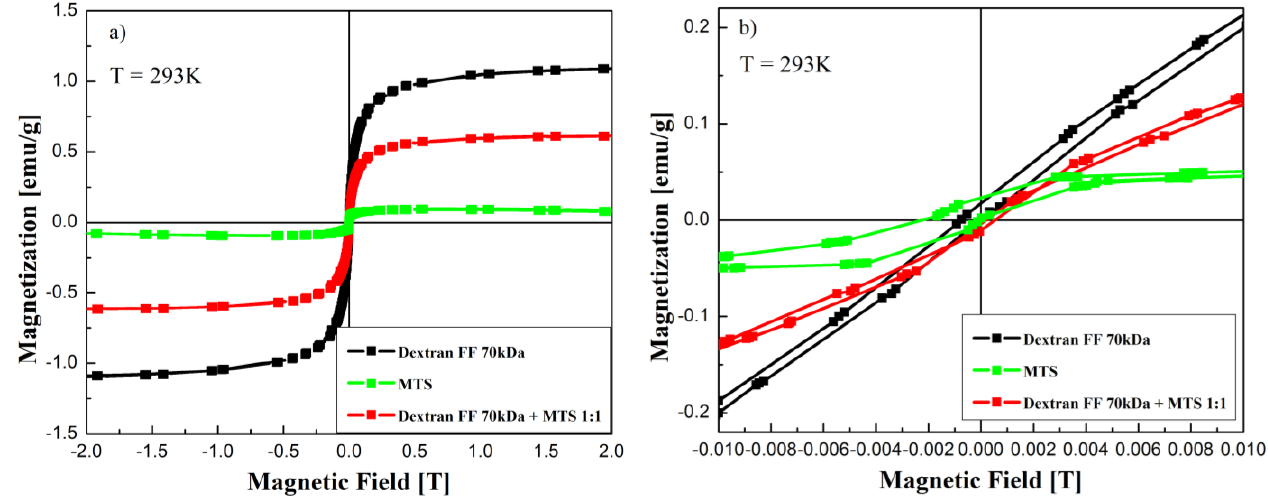
Figure 3. Hydrodynamic diameter distribution of magnetic fluid (dextran-coated Fe 3 O 4 nanoparti- cles), magnetosome chains, and the mixture of magnetic fluid and magnetosomes (ratio 1:1).